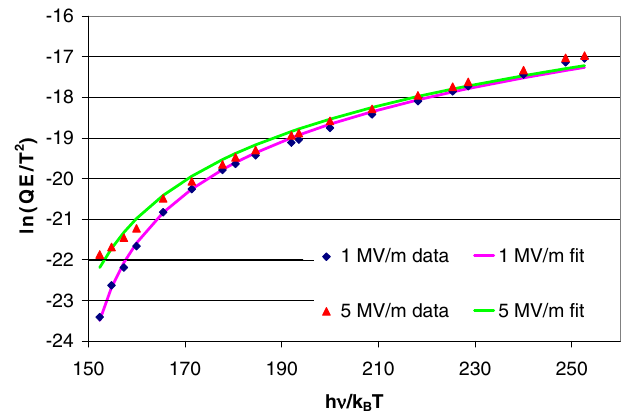
T for sputtered lead B